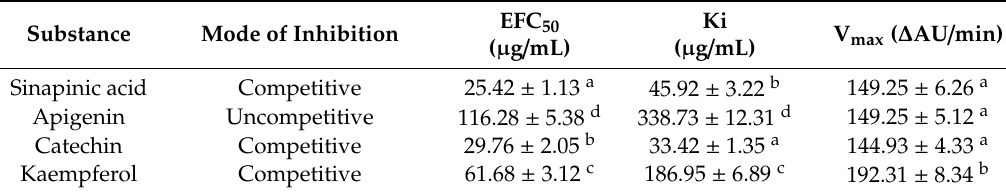
Table 3. The EFC 50 (e ff ective concentration), Ki, and V max values and mode of thyroid